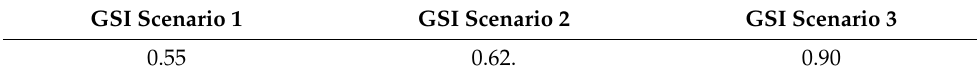
Table 5. Global Sustainability Indices (GSIs) for the three